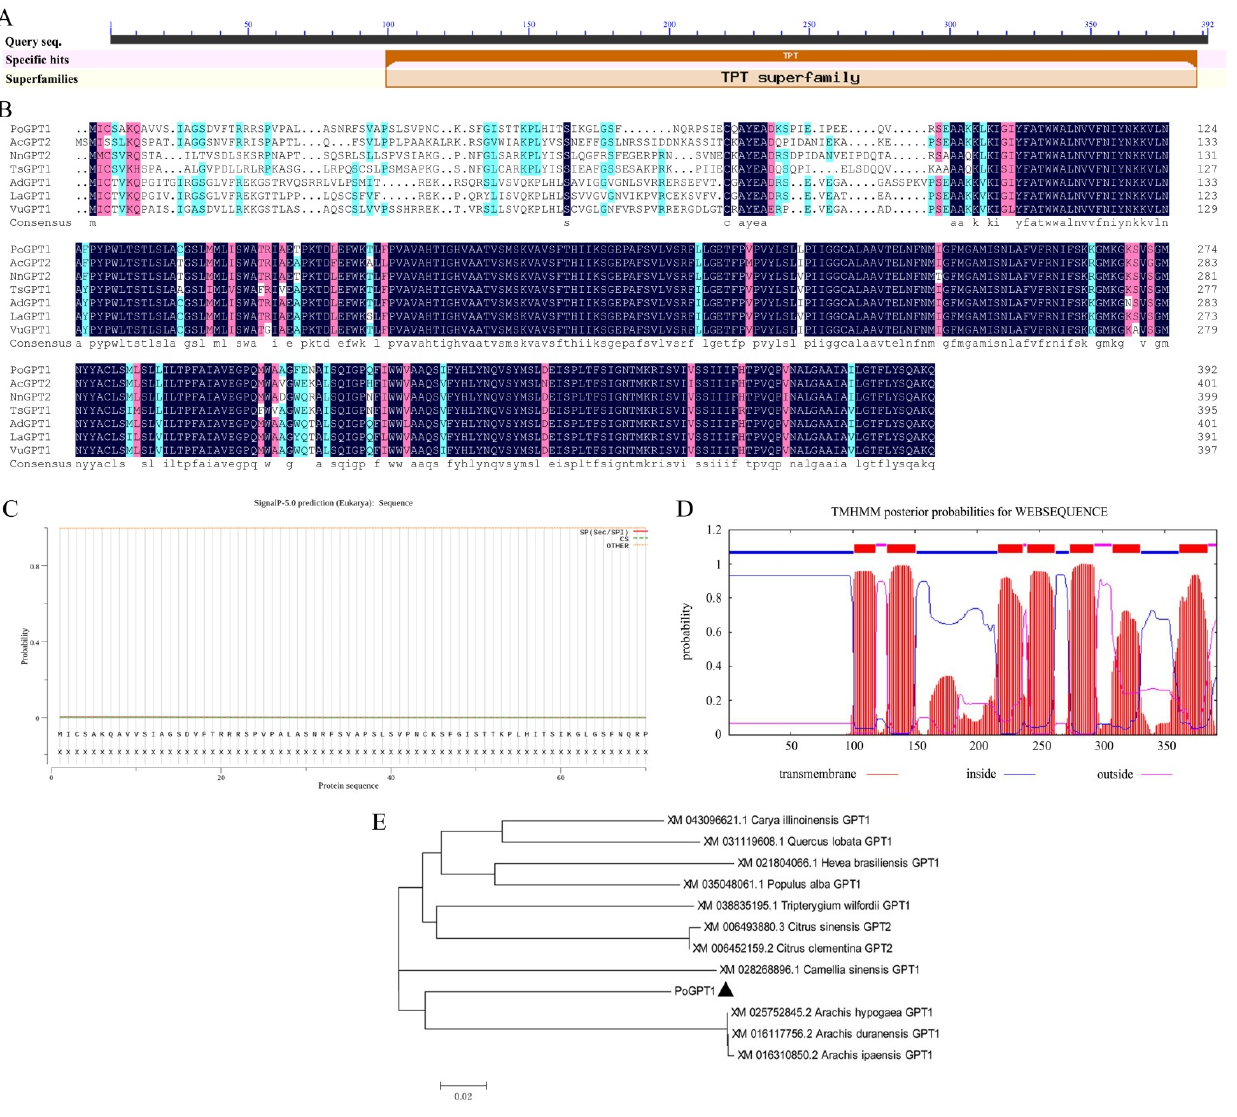
Figure 2. Protein structure and phylogenetic analysis of PoGPT1 (( A ), Conserved domains; ( B ), Sequence alignment, the color of amino acids from dark to light indicates their similarity from high to low; ( C ), Signal peptide analysis; ( D ), Transmembrane domain analysis; ( E ), Phylogenetic analysis).